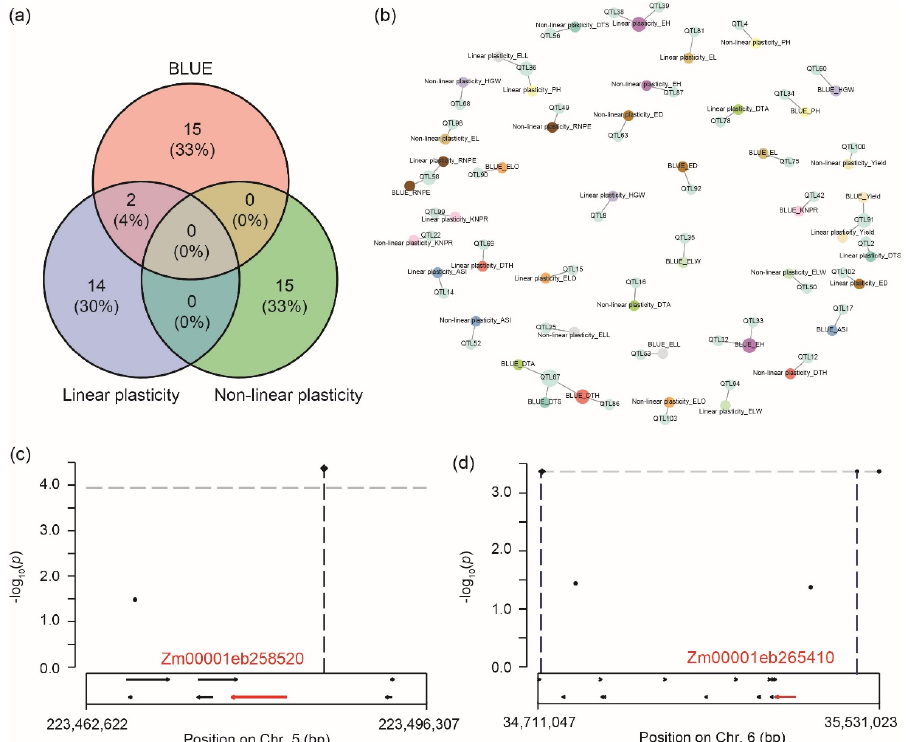
Figure 5. QTL mapping for 15 traits for the genotypic performance (BLUE) across seven environments, the non-linear plasticity, and the linear plasticity. ( a ) Venn diagram showing overlapping and specific QTL. ( b ) Trait-QTL network. The different colors represent different traits and QTL. ( c ) Identification of the gene Zm00001eb258520 as a candidate for QTL64 (chromosome 5: 223.44–223.64 Mb) detected for RNPE in the P-stress environment SZ.2019.P0. ( d ) Identification of the gene